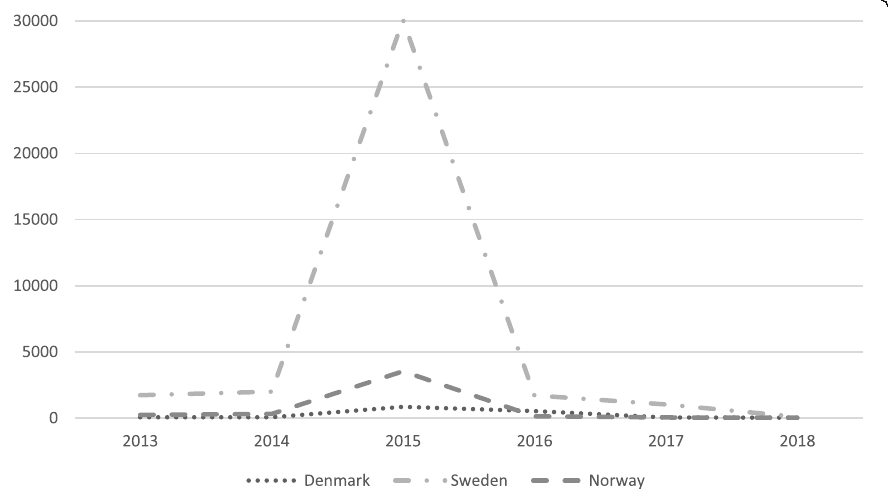
Fig. 1 Unaccompanied Afghan Asylum Applicants in Scandinavia 2013 – 2018 (Source: own compilation based on data from Udlæningestyrelsen (2018), Migrationsverket (2018) and UDI